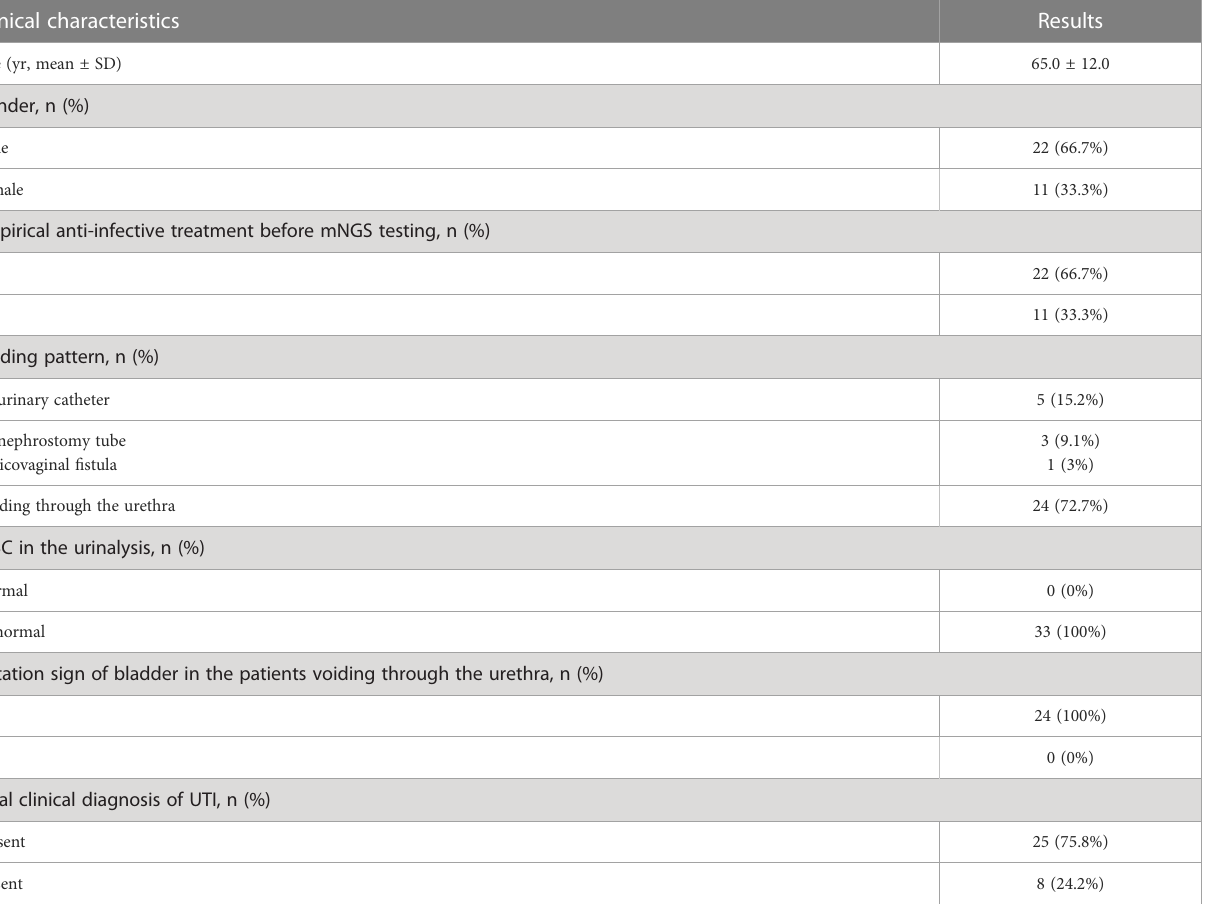
TABLE 1 Demographic and clinical characteristics of the 33 patients. Clinical characteristics